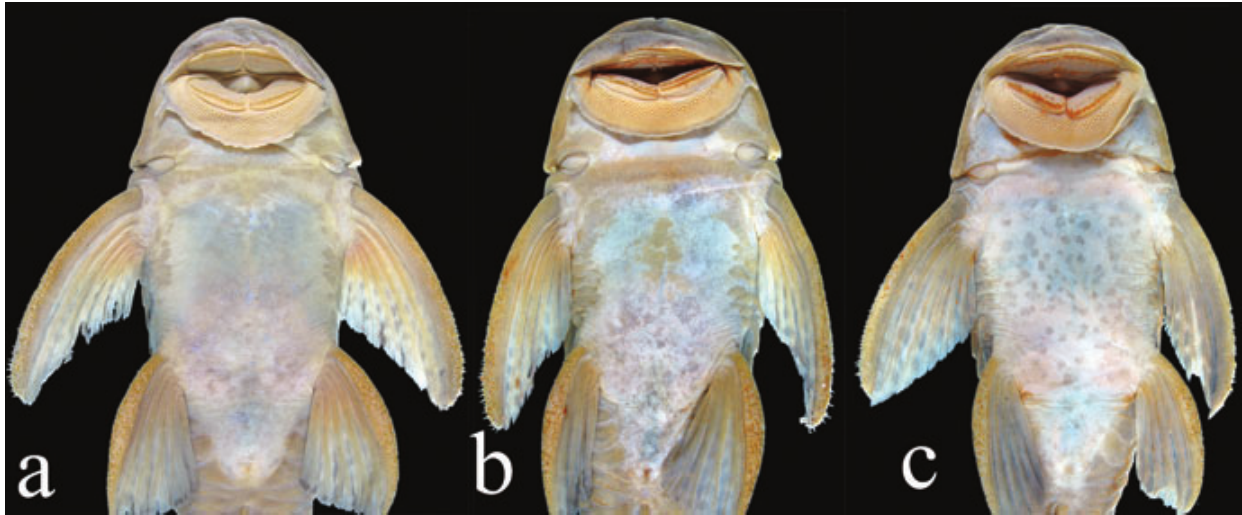
Fig. 3. Head and anterior portion of body in ventral view of Hypostomus kuarup , ( a ) MZUSP 109765, 157.0 mm SL, holotype, ( b ) MZUSP 94864, 147.0 mm SL, ( c ) MZUSP 94864, 115.0 mm SL, showing the variation of presence and arrangement of platelets ( a , b ), and abdominal color pattern ( c